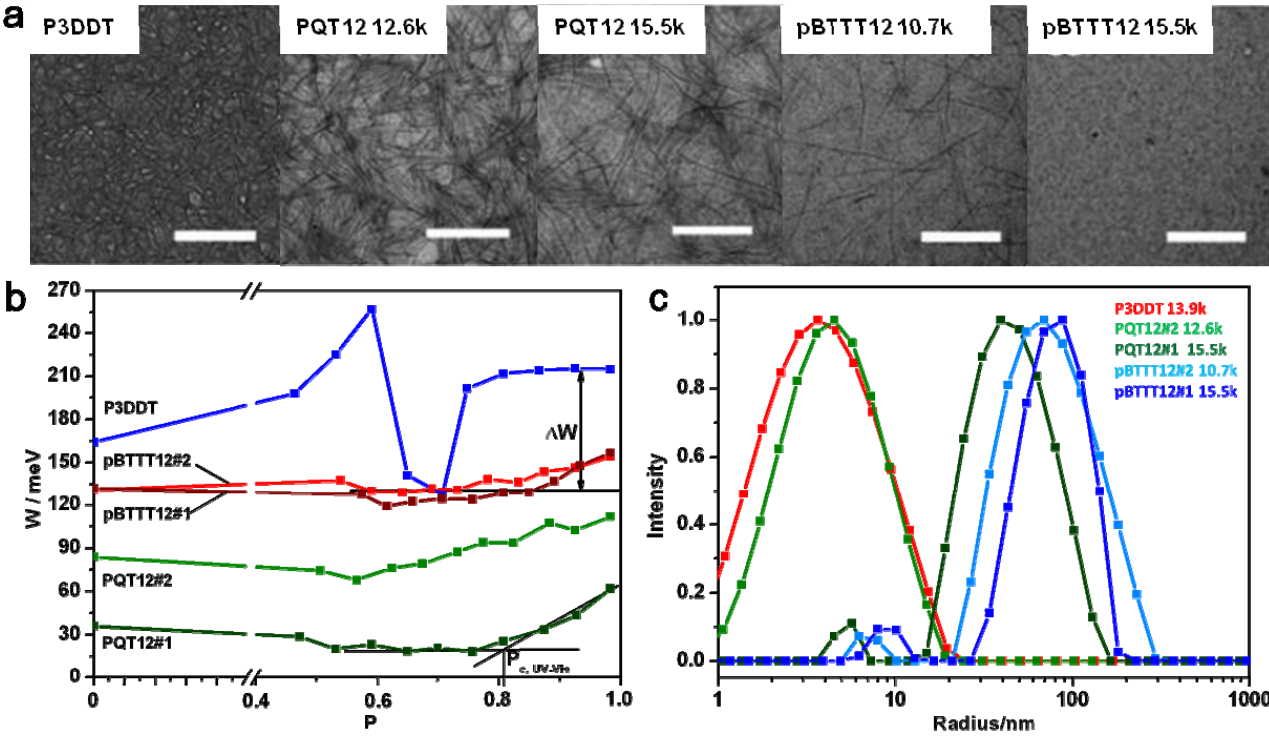
= 98.3% with a increasing Figure 7. The TEM images of films annealed at P CS2 conjugation length from left to right and scale bars of 500 nm in ( a ), the variation of free exciton bandwidth W with P indicating the conformation change in ( b ) and dynamic light scattering (DLS) results of polymers in solution in ( c ) (Adapted with permission from [79]. Copyright 2013 American Chemical